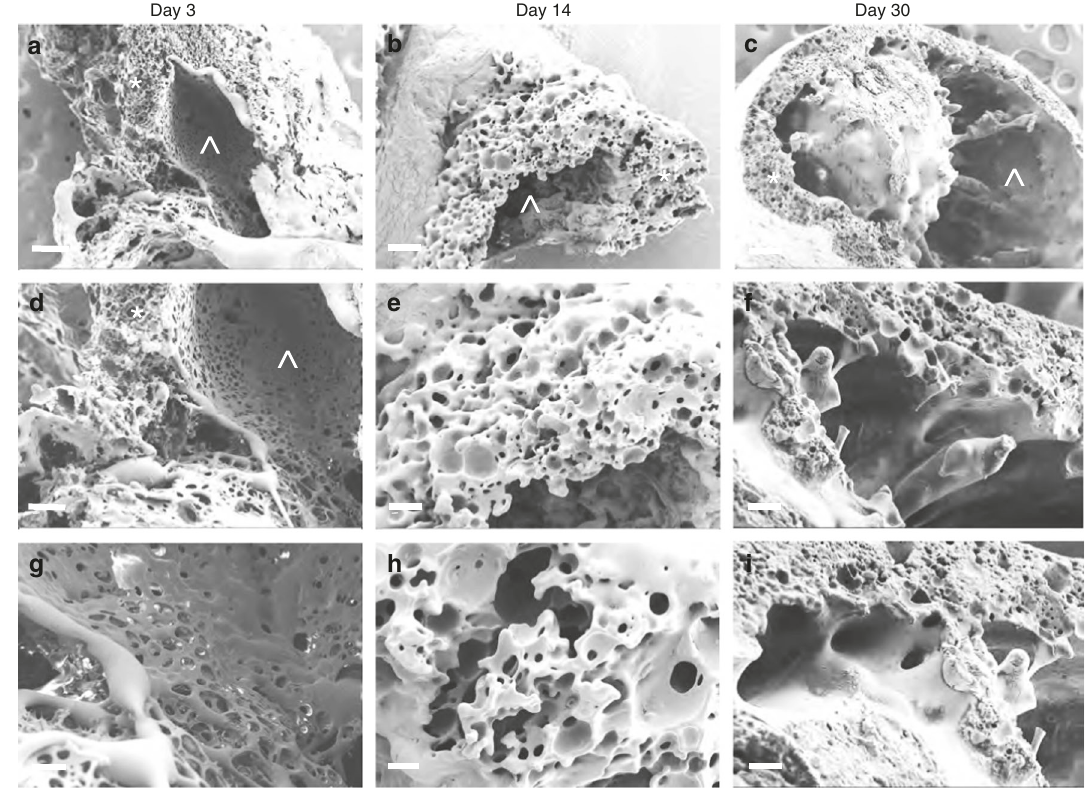
Fig. 2 Effect of PLGA degradation on implant microstructure. SEM cross-section images of placebo-ISFIs (1:2 w/w PLGA/NMP, PLGA MW 27 kDa) over a 30 day period ( n = 3). a – c low magni fi cation image (×100 ) of the entire implant (scale bar = 100 µ m), d – f higher magni fi cation (×200) of the implant shell (shell thickness was measured using SEM scale; scale bar = 50 µ m), g – i higher magni fi cation (×500) of the center of the implant (scale bar = 20 µ m). a , d , g Implants imaged at day 3 post incubation in 0.01 M PBS pH 7.4 at 37 °C; b , e , h implants imaged at day 14 post incubation; c , f , i implants imaged at day 30 post incubation. Representative image for each magni fi cation and time point is shown ( n = 3). Symbols represent implant shell (*) and pore